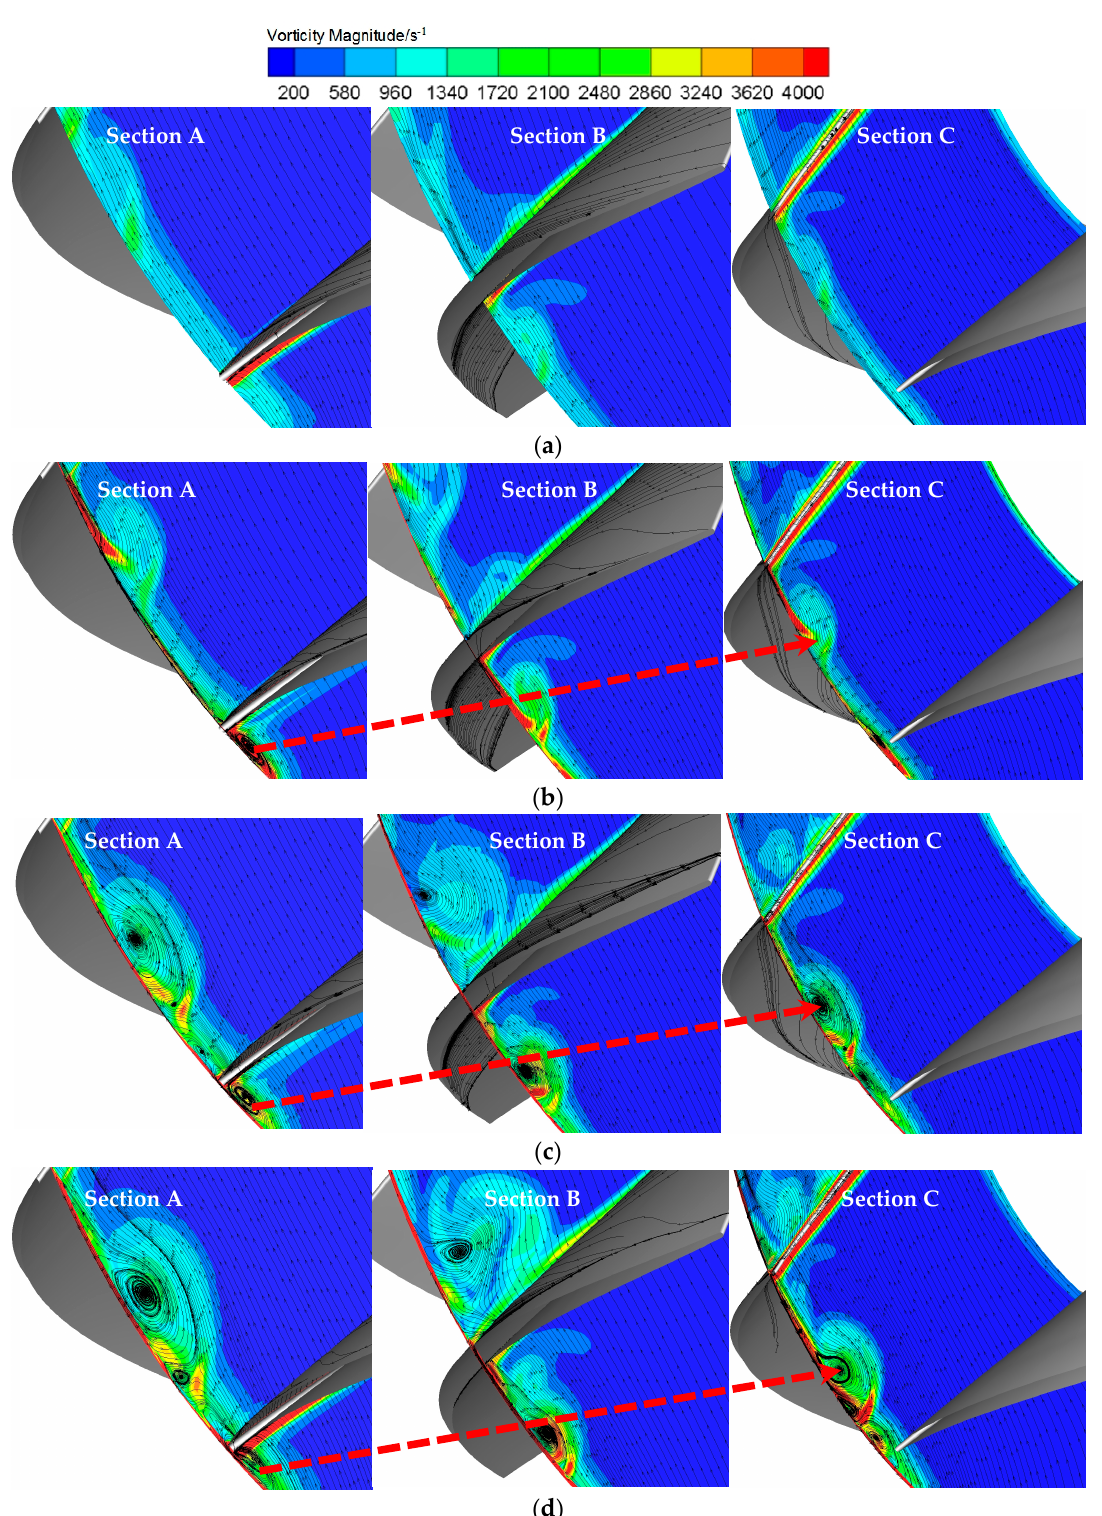
Figure 10. Streamline and vortex distribution on axial sections. ( a ) δ = 0.0 mm; ( b ) δ = 0.2 mm; ( c ) δ = 0.65 mm; ( d ) δ = 1.0